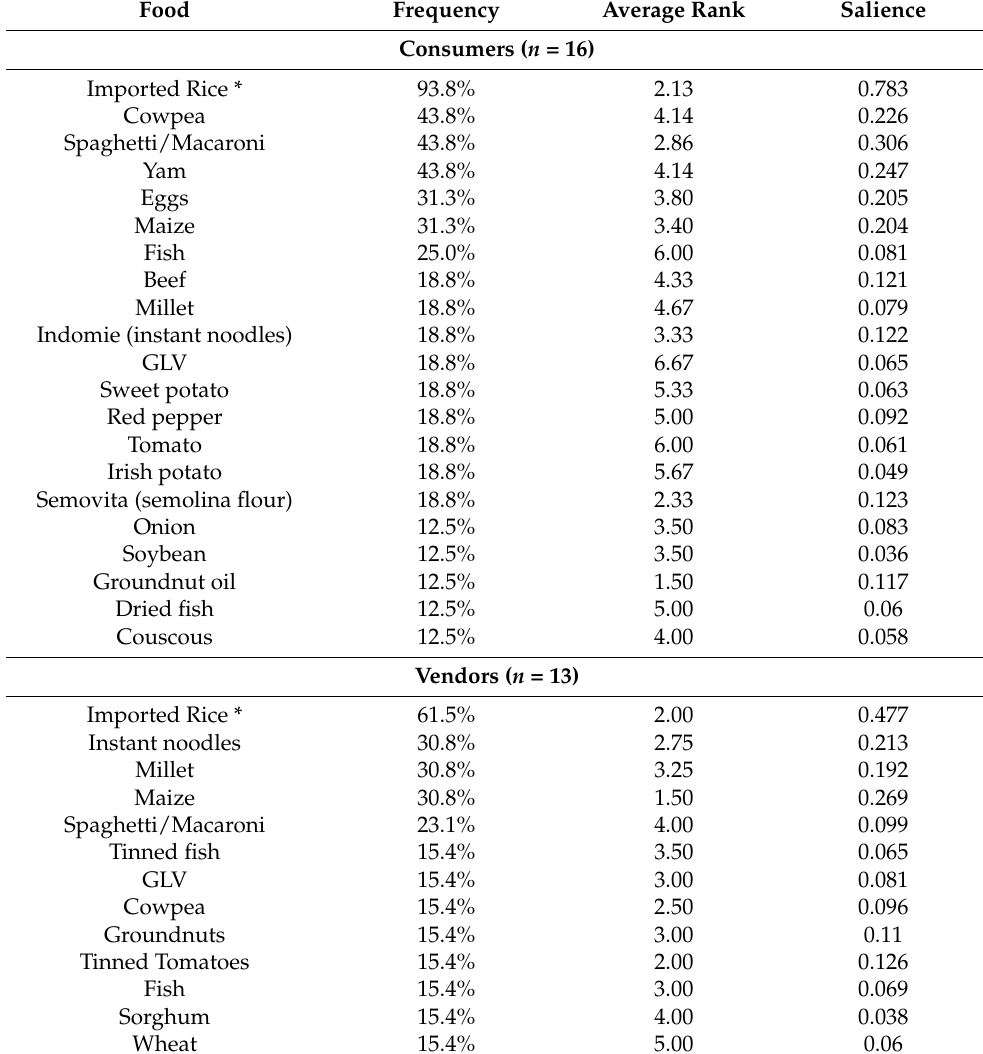
Table 4. Free-list results for “safe